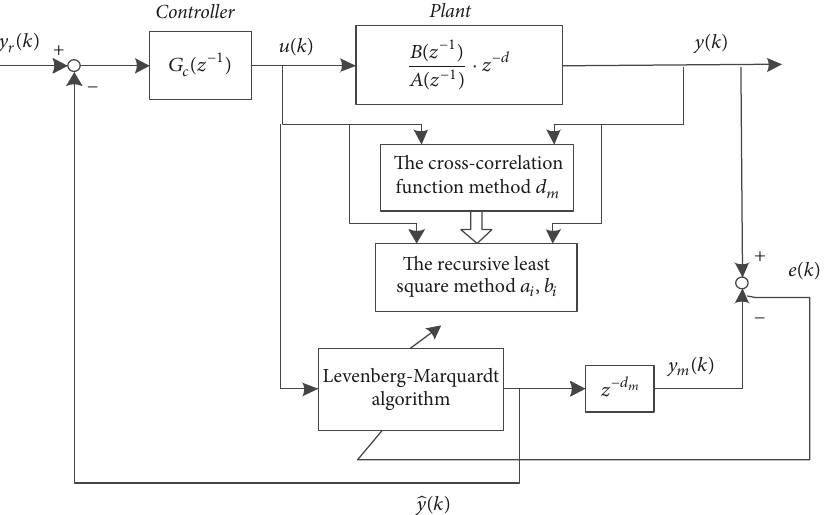
Figure 4: An identification and control scheme for the monitoring AGC system.